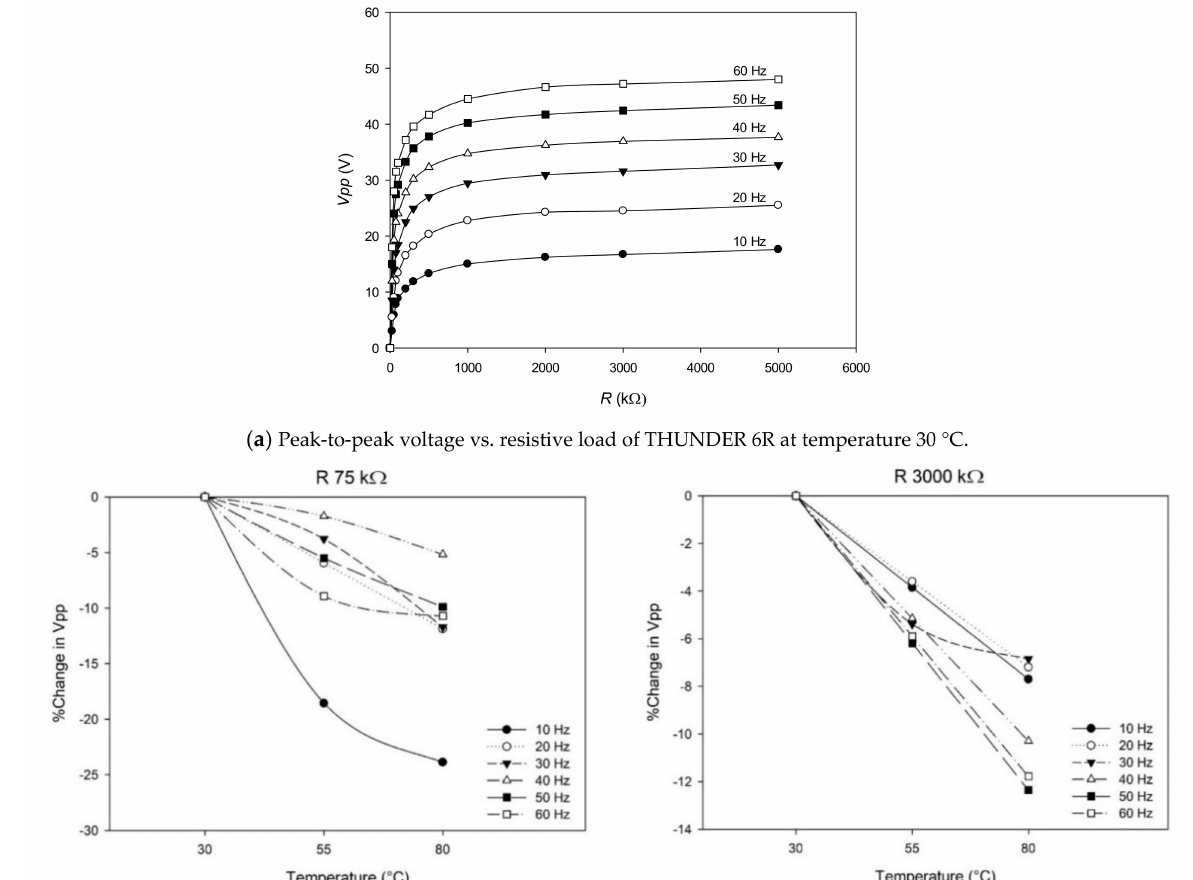
Figure 11. Peak-to-peak voltage and its percentage changes of THUNDER 6R at δ = 1.6 mm. ( a ) Peak-to-peak voltage at 30 ◦ C under resistive loads. ( b ) Percentage change in peak-to-peak voltage vs. temperature at R = 75 k Ω . ( c ) Percentage change in peak-to-peak voltage vs. temperature at R = 3000 k Ω